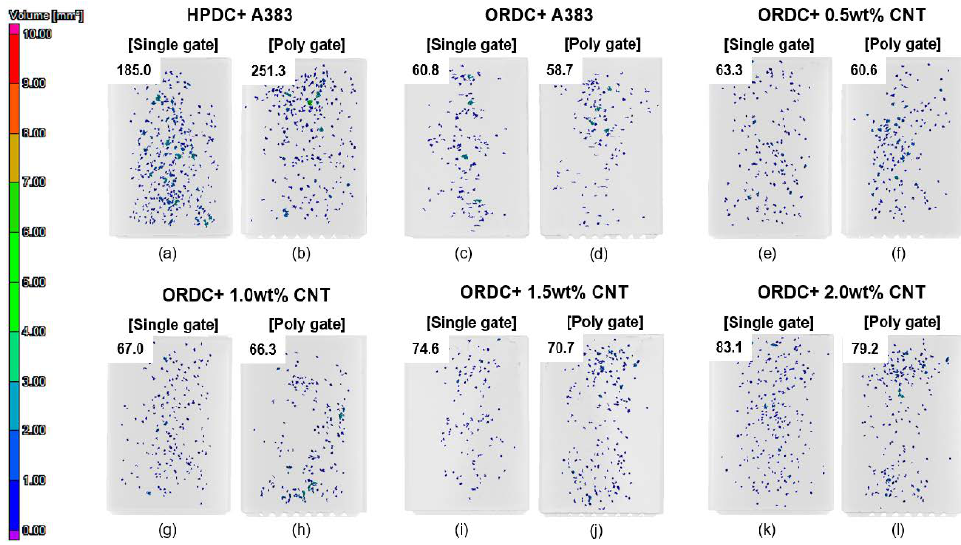
Figure 10. X-ray CT images and porosity analysis of A383 alloy cast using a single gate and poly gate by using ( a , b ) HPDC and ( g , h ) ORDC, respectively; 0.5–2.0 wt% CNT-added composites cast using ( c , e , g , i , k ) a single gate and ( d , f , h , j , l ) poly gate by using ORDC.